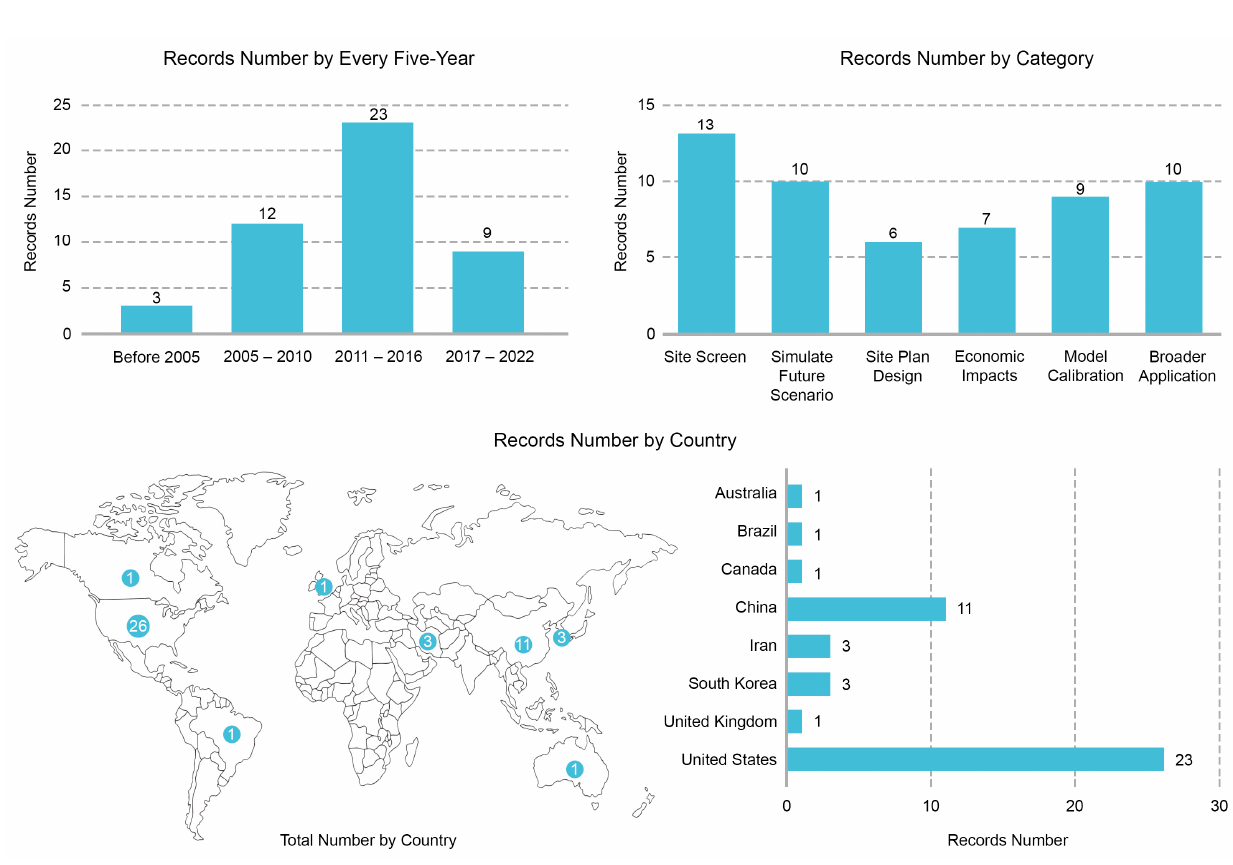
Figure 3. Descriptive results of 47 selected articles.